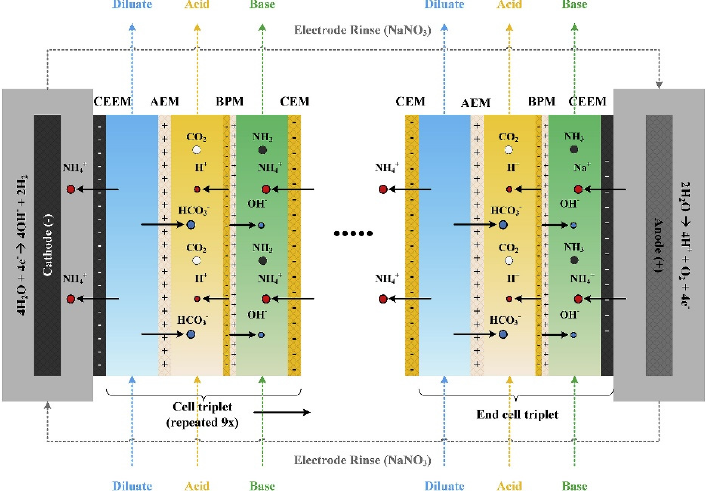
Figure 16. The membrane and (flow) cell sequence in the BMED and the intended ion transport (electromigration and water dissociation) as a result of the applied current. In the acid, H + and HCO 3 − are combined and react to CO 2 , while in the base, OH − and NH 4+ are combined and react to NH 3 . At the cathode, NH 4+ is transported to the electrode rinse, while at the anode, both Na + and NH 4+ are transported to the base, resulting in the accumulation of NH 4+ in the electrode rinse and the washing out of Na + to the base [100].